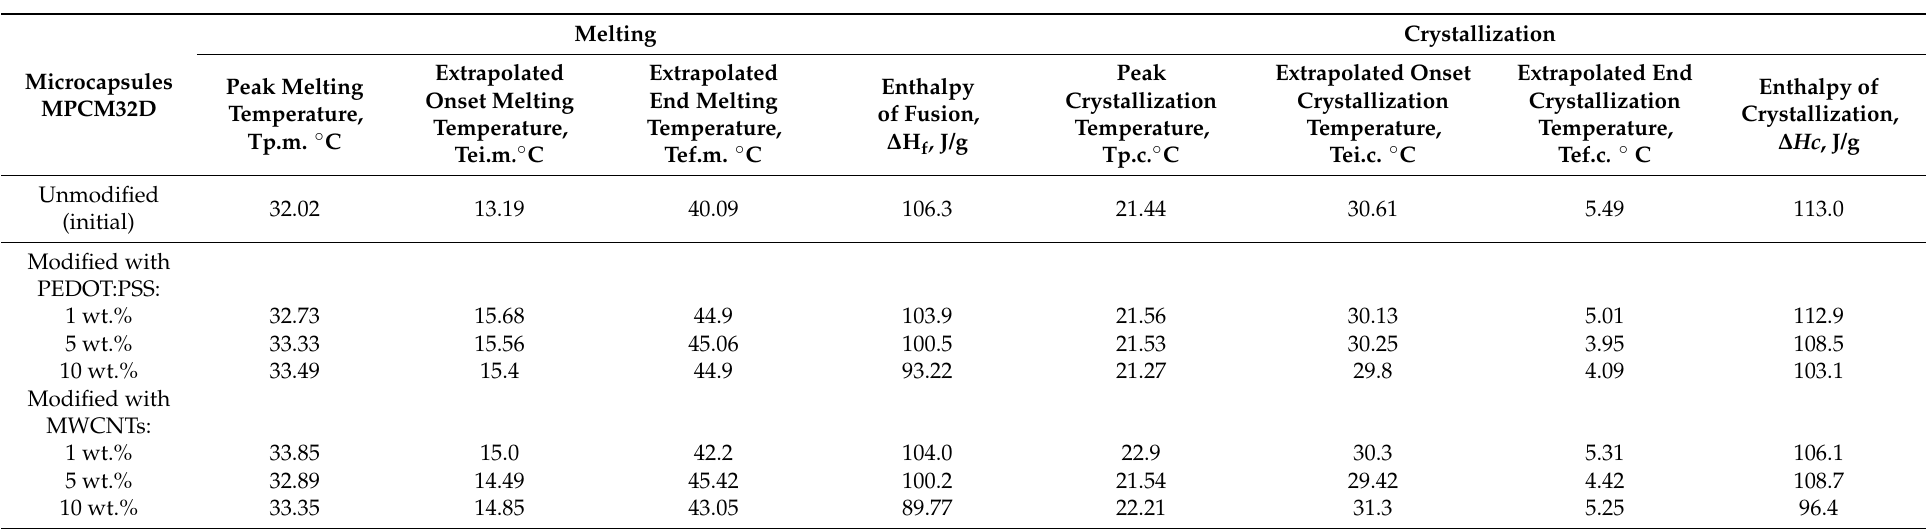
Table 3. DSC results of the unmodified and shell-modified microcapsules